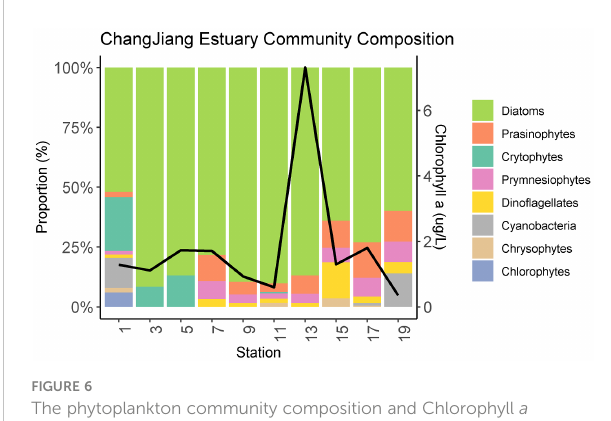
FIGURE 6 The phytoplankton community composition and Chlorophyll a concentration (solid black line) in the surface water of Changjiang River Estuary in summer along the transect C, according to high- performance liquid chromatography (HPLC) and CHEMTAX analysis. Phytoplankton species include Diatoms, Prasinophytes, Crytophytes, Prymnesiophytes, Dino fl agellates, Cyanobacteria, Chrysophytes, And